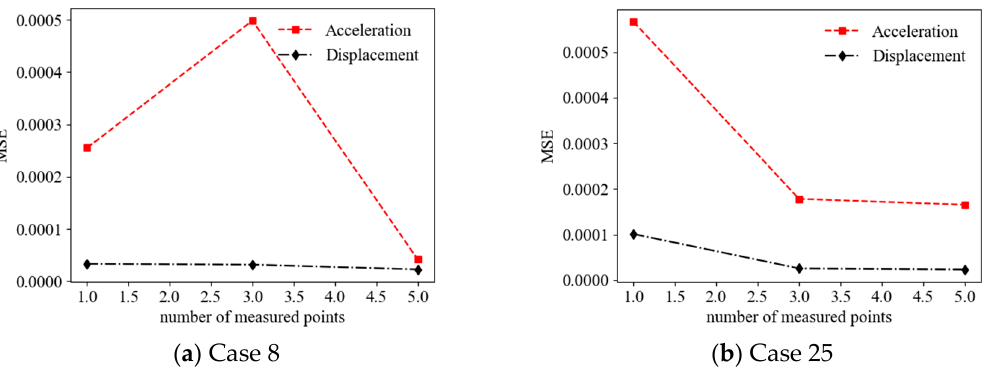
Figure 12. Prediction results of structural damage using displacement responses from different measurement points as ANN input.